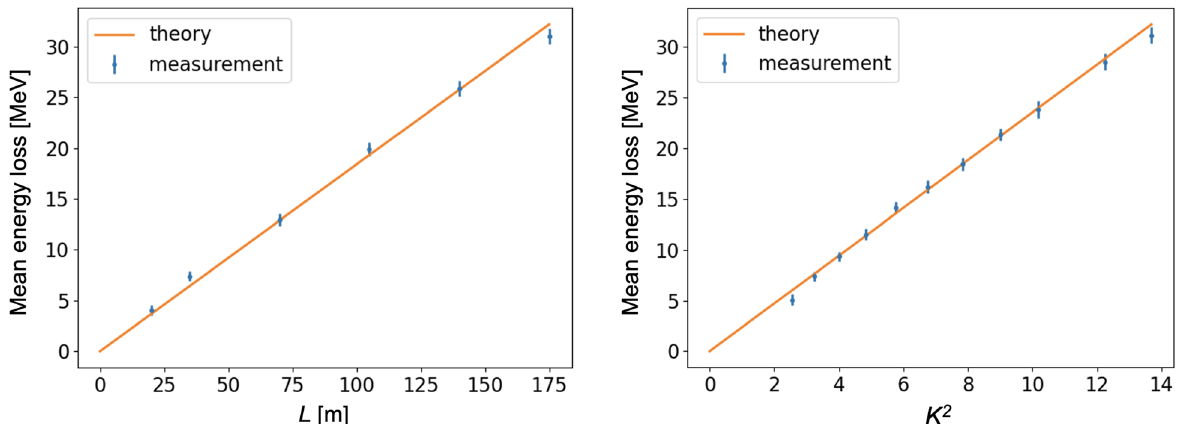
Figure 5. The mean beam energy loss due to synchrotron radiation. The left plot shows measurements of the beam energy loss for a range of undulator magnetic lengths L . The right plot shows measurements of the beam energy loss for a range of the undulator K parameters. Theoretical lines obtain with Eq.